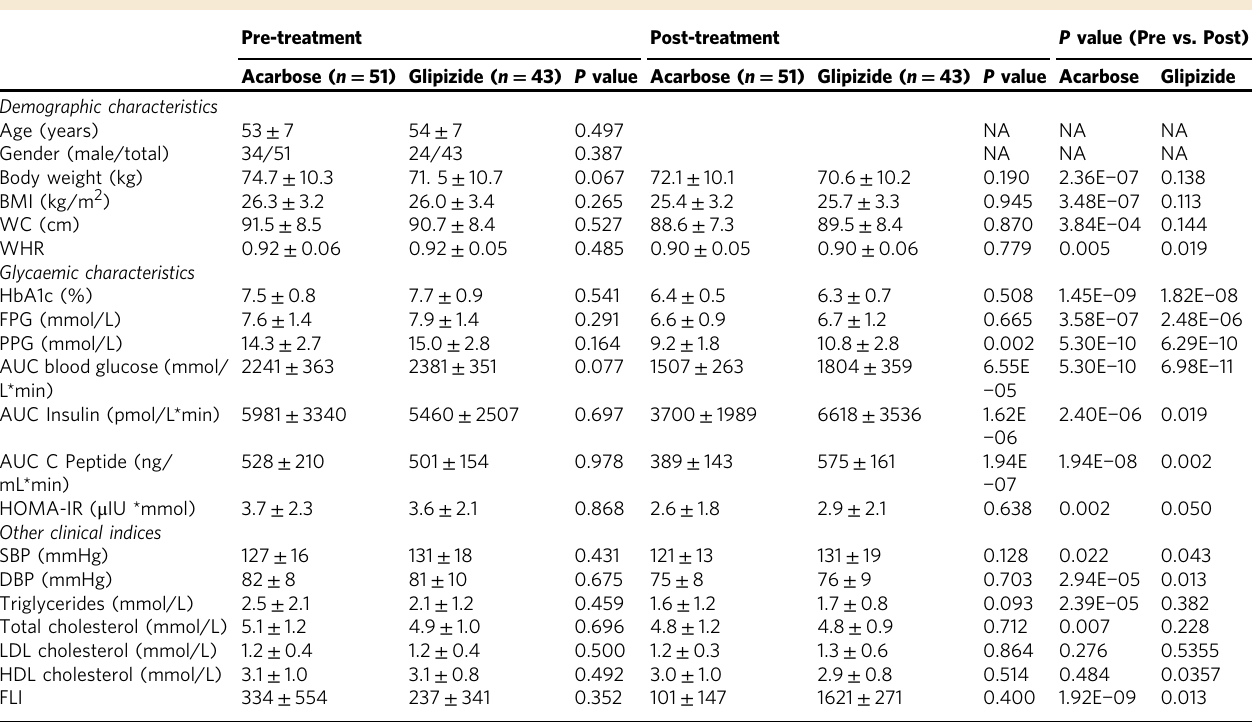
Table 1 Clinical parameters in the pre-treatment and post-treatment samples in the two treatment arms Pre-treatment Post-treatment P value (Pre vs.